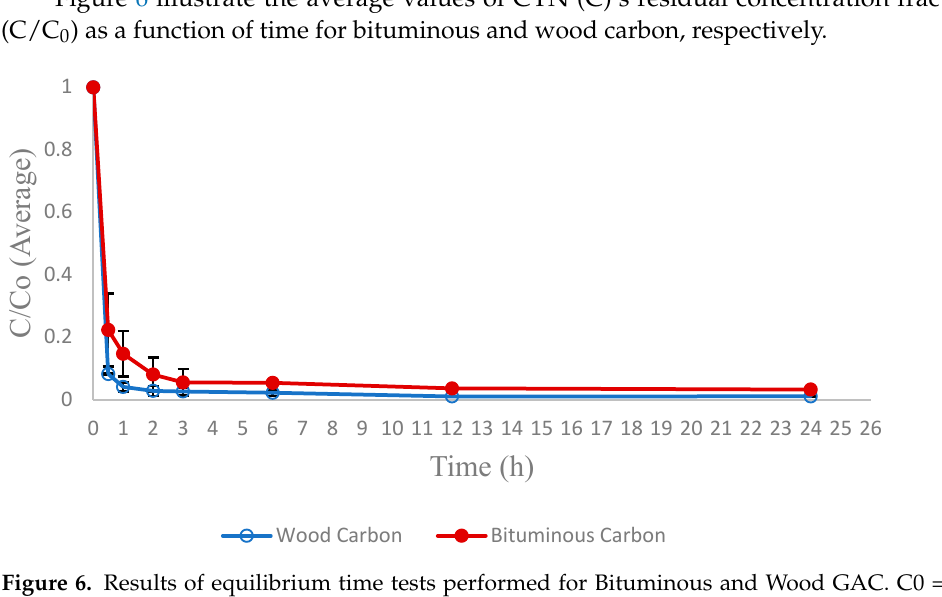
Figure 7. CYN removal as a function of the applied carbon concentration in Paranoá lake water matrix (C0—Bituminous Carbon = 102.23 μ g/L; C0—Wood Carbon = 89.24 μ g/L); initial pH of the study water = 6.5. Base water: pH = 7.7; Turbidity = 0.07 uT. Wood carbon showed higher percentages of CYN removal for the range of concentrations studied. The higher CYN adsorption capacity may be related to the higher volume of mesopores of wood carbon, which may have favoured the retention of the CYN